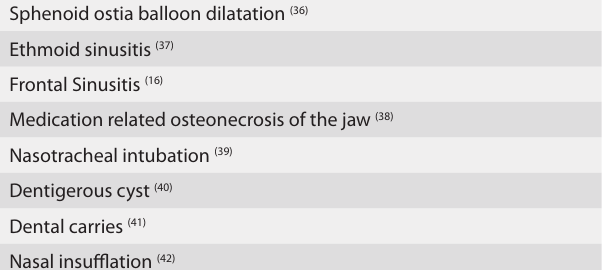
Table 2. Rare causes of NSH and NSA.